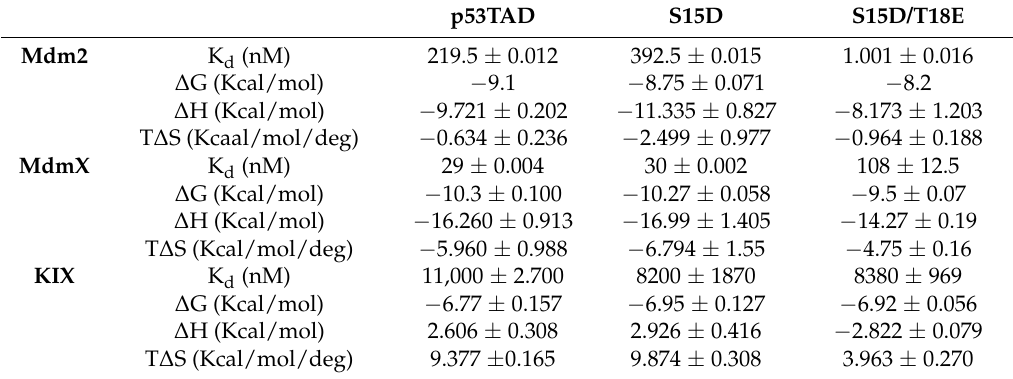
Table 1. Isothermal titration calorimetry (ITC) values for interactions between Mdm2, MdmX and KIX with p53TAD and